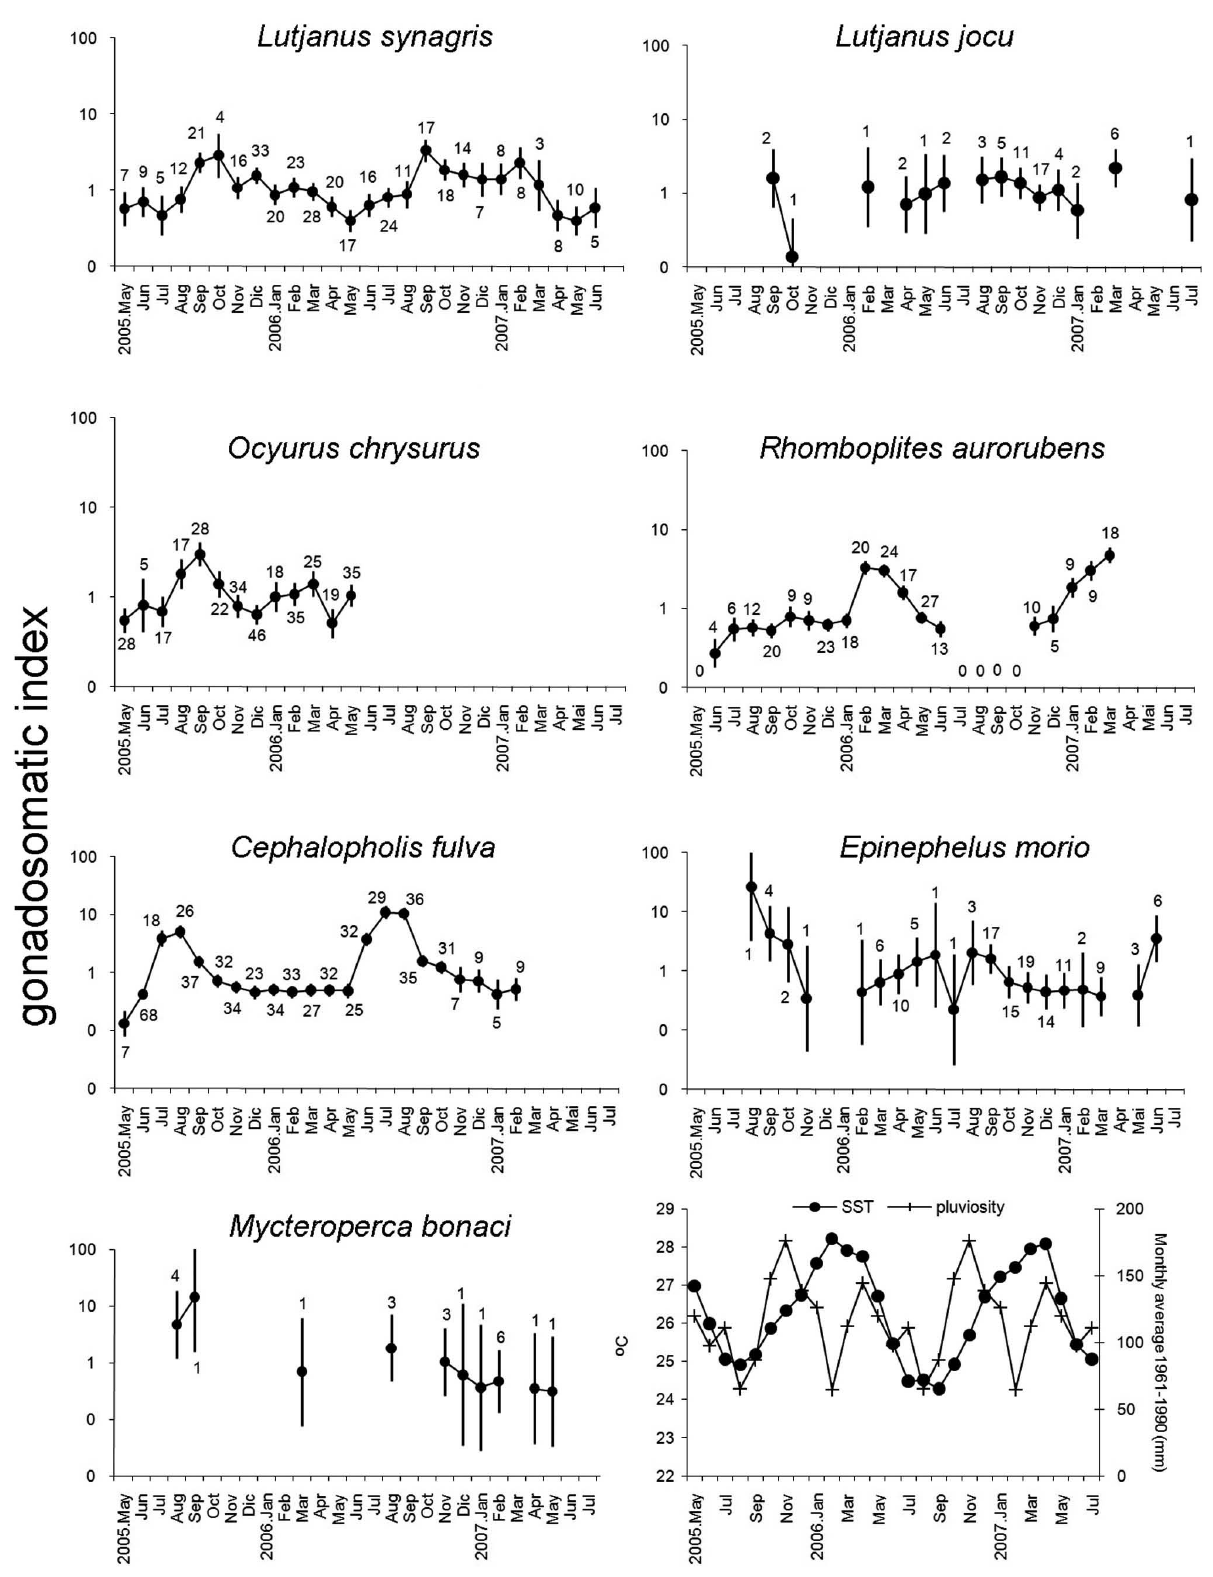
Fig . 2. – Temporal variation in the Gonadosomatic Index (GSI) for seven commercially important reef fish species, as well as for air tempera- ture and rainfall. Estimates of the expected GSI values (dots) and their 95% confidence limits